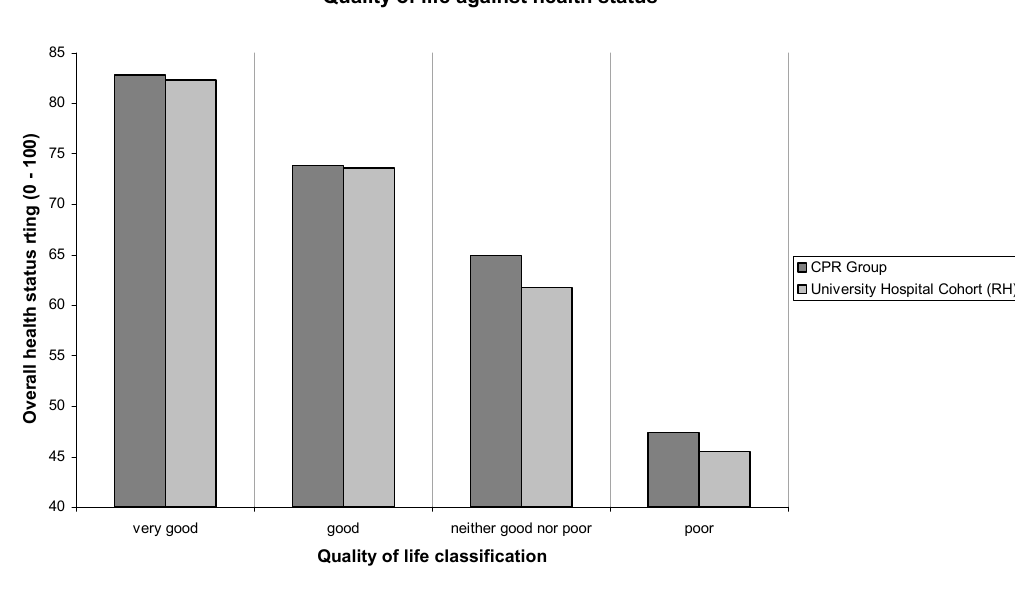
Figure 2. Global quality of life against health status. The statistical co-variation is about 40% in both studies. This is a far stronger co-variation than is seen between lifestyle and health (Figure 1), and between quality of life and lifestyle (Figure 3), suggesting that global QOL is the most important factor for preventing disease and improving